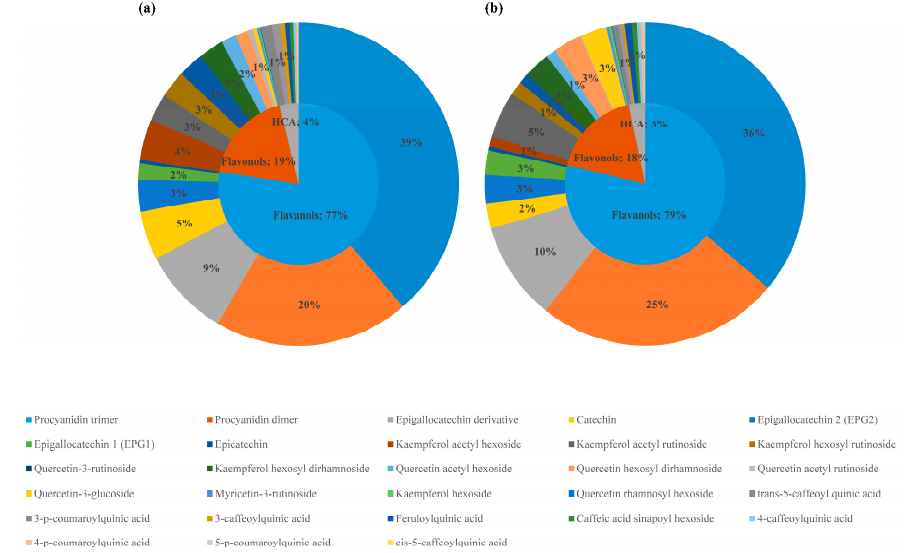
Figure 2. Representation (%) of main phenolic classes (flavanols, flavonols, and hydroxycinnamic acids (HCAs) and individual phenolic compounds determined in stems of ( a ) susceptible and ( b ) resistant hop cultivars.